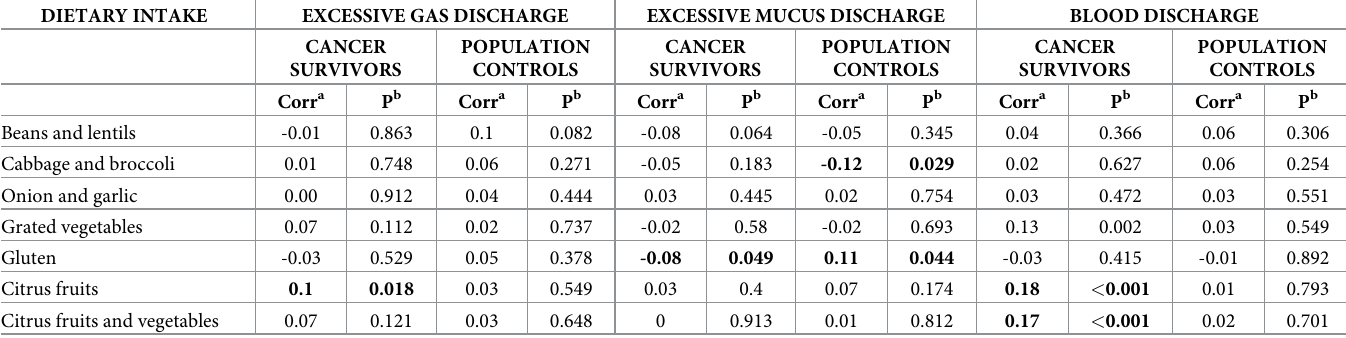
Table 3. Spearman correlation coefficient and corresponding P-values for the relationship between dietary intake and radiation-induced survivorship syndromes among gynecological cancer-survivors and population controls. DIETARY